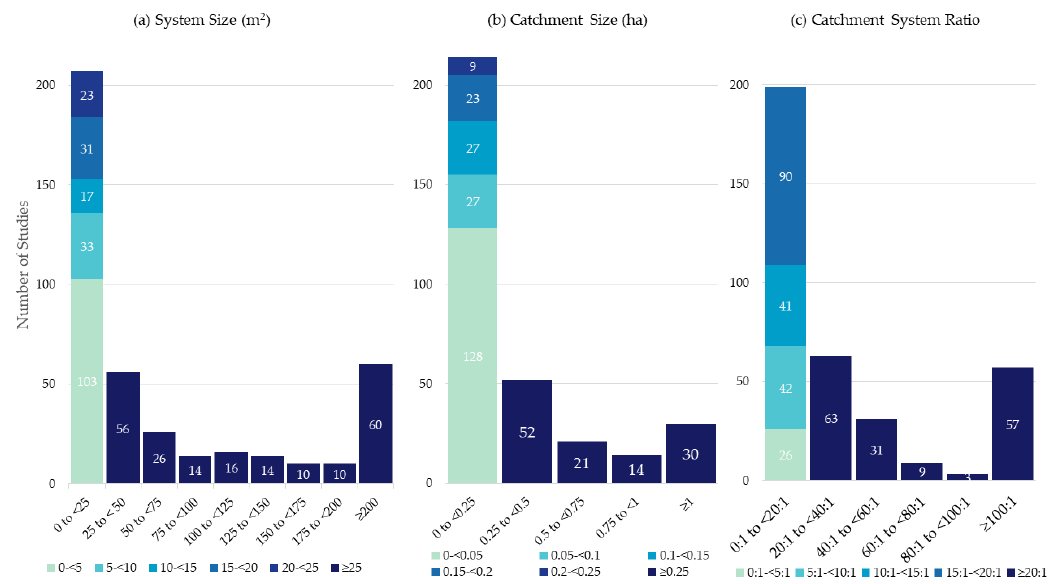
Figure 6. Histogram of system size ( a ), catchment size ( b ) and catchment area to system size ratio ( c ).